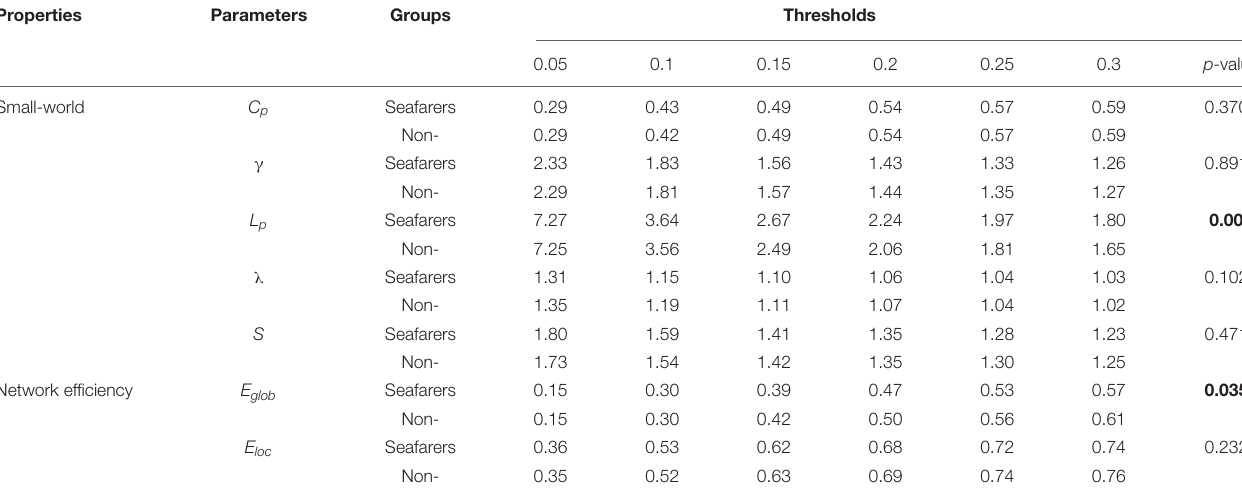
Values in bold indicate statistically significant